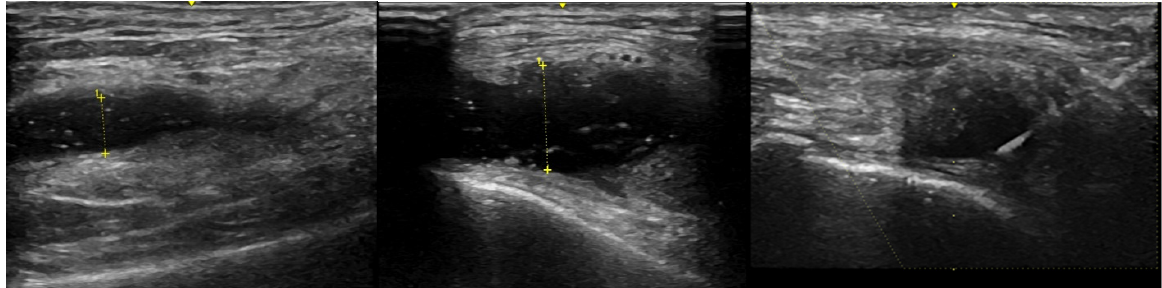
Figure 1. US images from a single OA patient displaying the maximum synovial fluid (anechoic) region from the lateral knee. The left panel was baseline before external pneumatic compression (SF depth was 5.8 mm), middle panel was after inflation to 100 mmHg (SF depth was 10.9 mm) and the right panel is of needle insertion during aspiration while the device remained inflated.